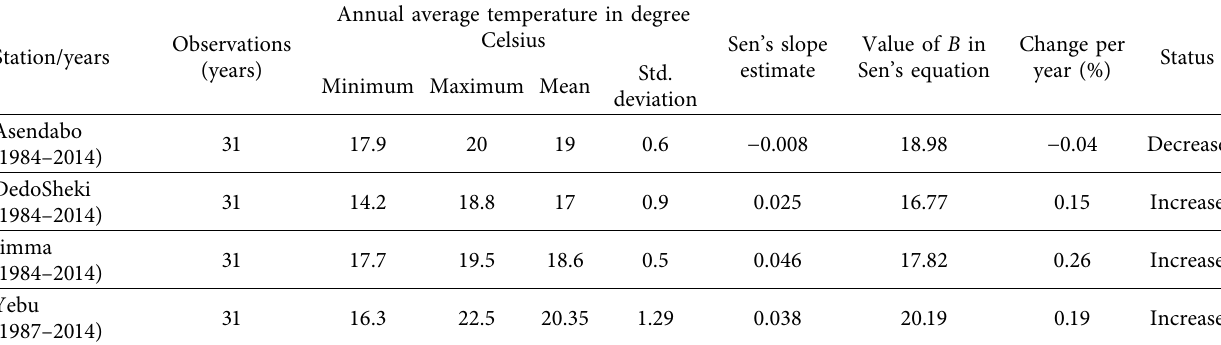
Table 4: Summary of the true slopes of the existing trend for